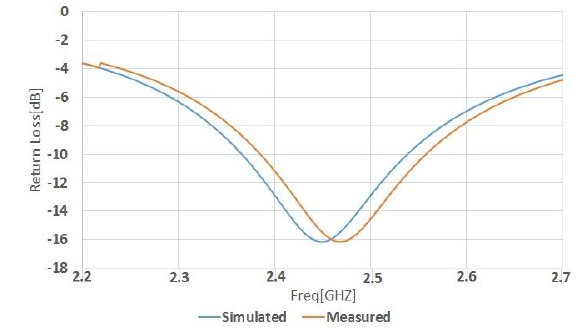
Figure 7. Simulated and measured return loss vs Freq. of prototype antenna